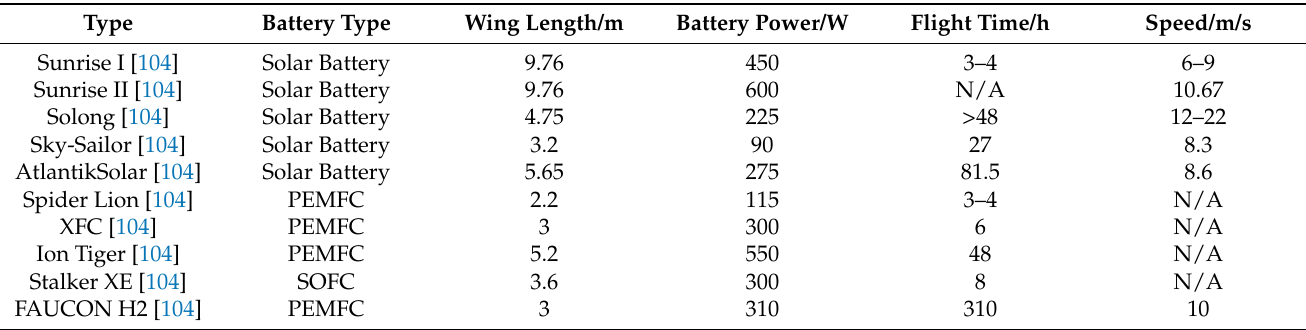
Table 6. Comparison between fuel cells and solar UAVs